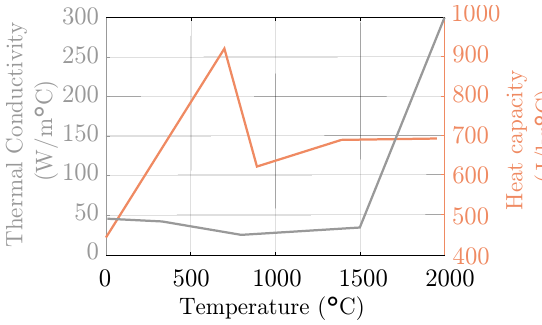
Figure 2. Temperature dependent thermal material properties derived from